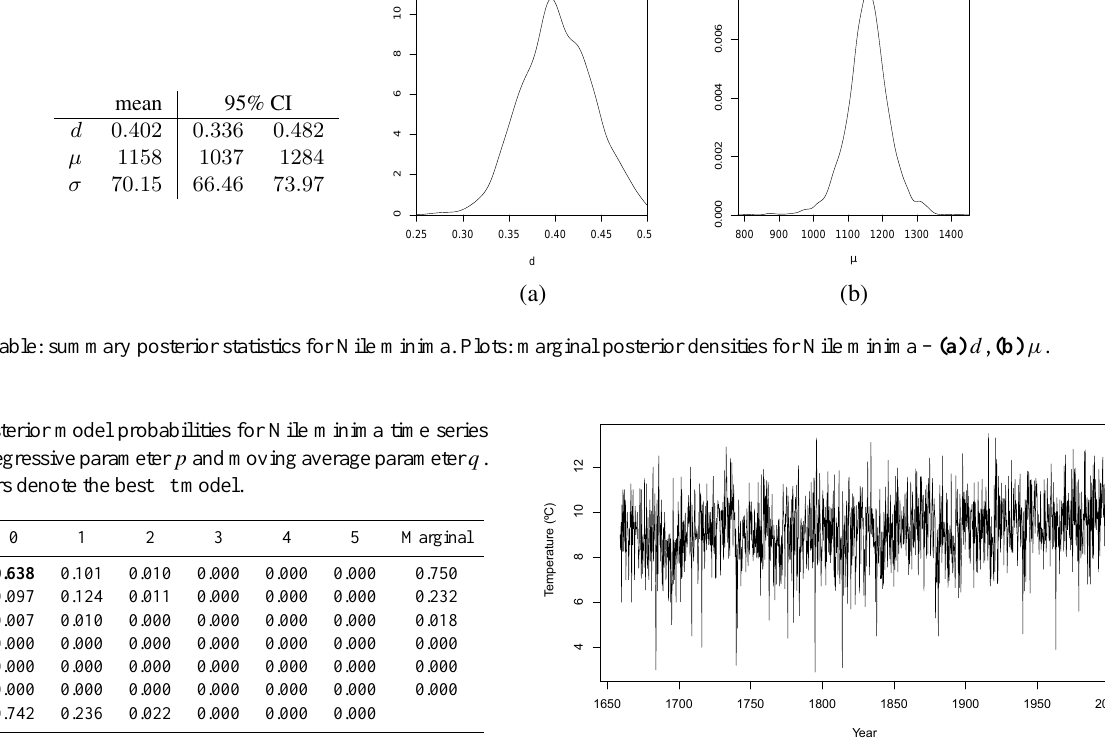
Figure 13. CET time series (deseasonalized). a credibility interval of (0.316, 0.475) using their Bayesian FEXP